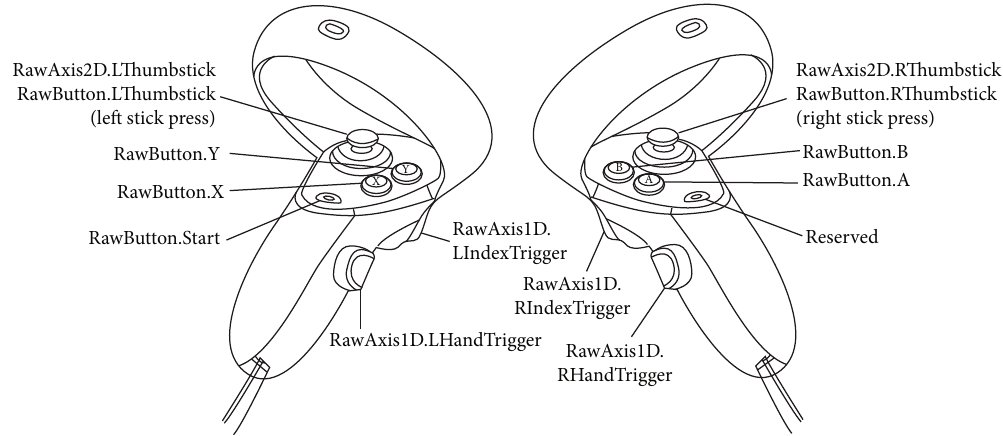
Figure 1: OVRInput API for unity uses to query controller state.